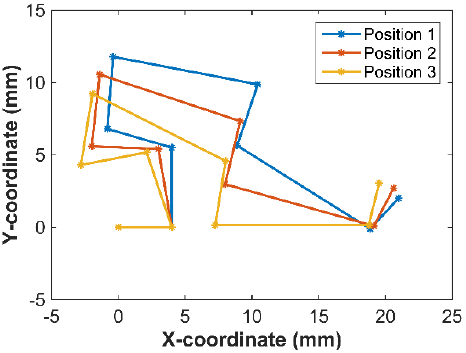
Figure 2. Forward kinematics simulation representing the link position with joint angle variation.